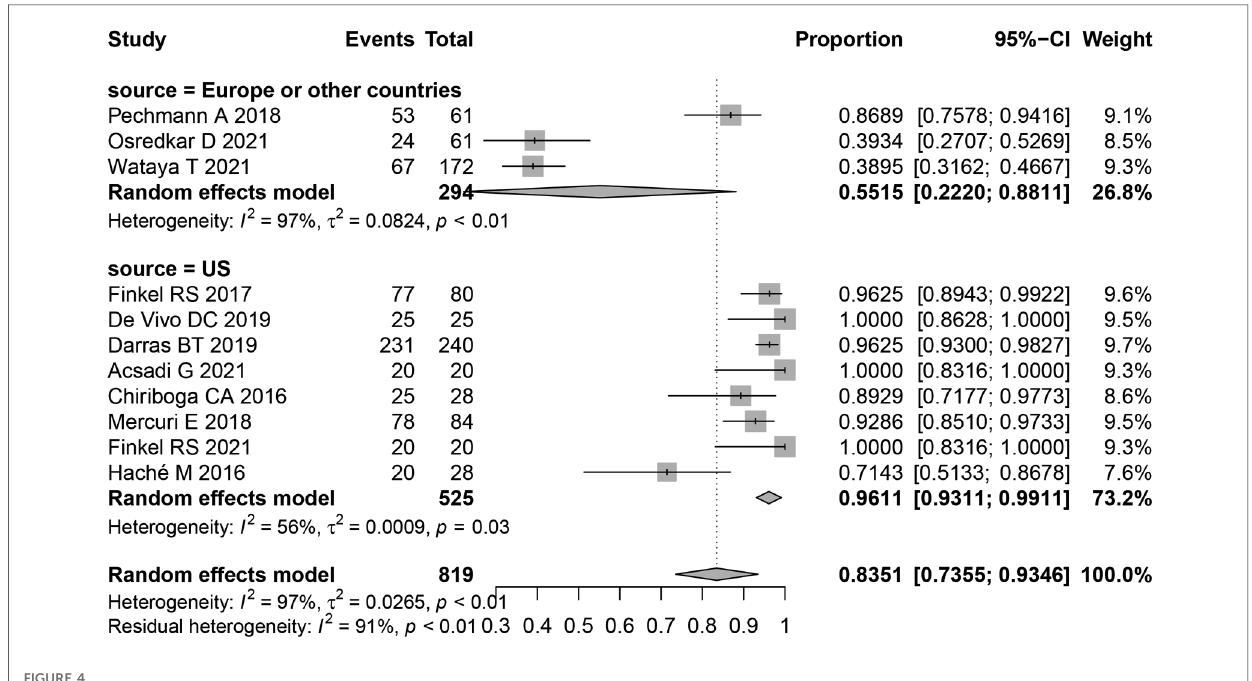
FIGURE 4 Forest plot of AEs subgroup